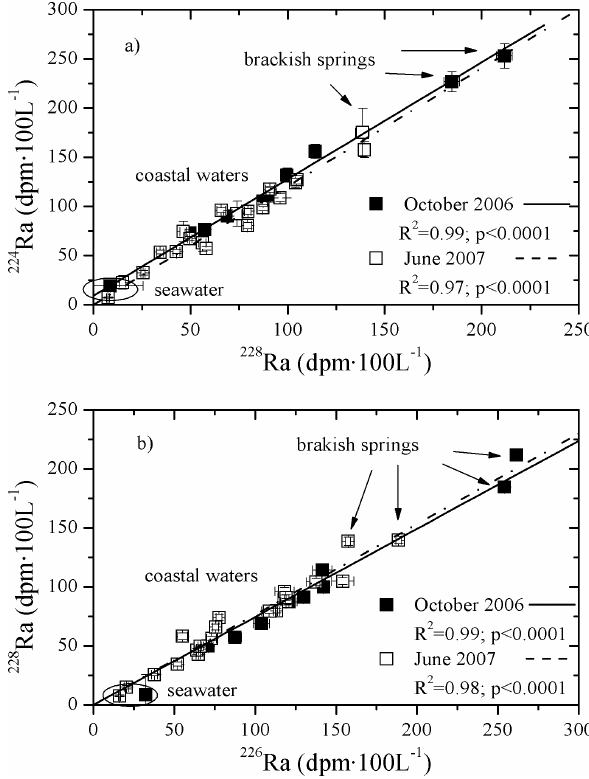
Fig. 4. 224 Ra vs. 228 Ra (a) and 228 Ra vs. 226 Ra (b) plots for sur- face coastal waters, seawater and coastal springs. The significant positive linear correlations among them suggest surface waters are affected by binary mixing between seawater and spring groundwa-